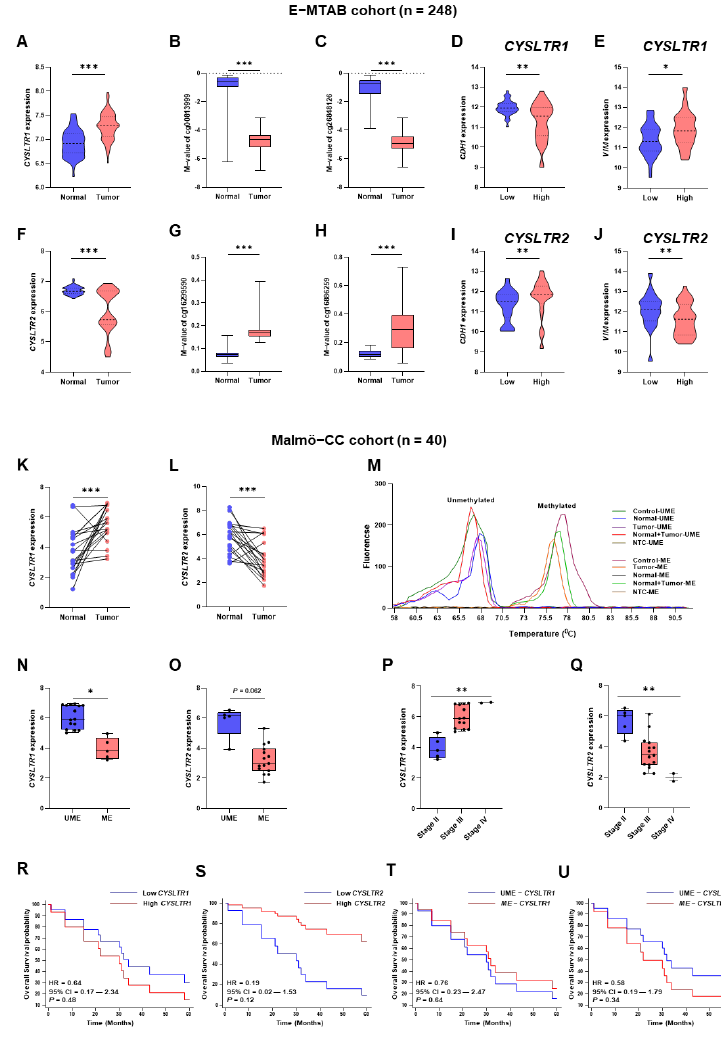
Figure 6. Expression and DNA methylation of CYSLTR1 and CYSLTR2 genes in the E-MTAB in silico and Malmö-CC clinical cohort. Relative expression of CYSLTR1 ( A ) and M-value distribution of cg00813999 ( B ) and cg26848126 ( C ) between normal and tumor samples, CDH1 ( D ), VIM ( E ) gene expressions in low- and high-expressed CYSLTR1 groups of patients in E-MTAB cohort. Relative expression of CYSLTR2 ( F ) and M-value distribution of cg16299590 ( G ) and cg16886259 ( H ) between normal and tumor samples, CDH1 ( I ), VIM ( J ) gene expressions in low- and high-expressed CYSLTR2 groups of patients in E-MTAB cohort. Relative expression of CYSLTR1 ( K ) and CYSLTR2 ( L ) gene expression between normal (N) and primary tumor (PT) samples in the Malmö cohort. ( M ) Quantita- tive methylation-specific PCR melting curve analysis in N and PT samples from the Malmö cohort. CYSLTR1 ( N ) and CYSLTR2 ( O ) gene expressions in unmethylated and methylated ( CYSLTR1 and CYSLTR2 ) patient groups in the Malmö cohort. CYSLTR1 ( P ) and CYSLTR2 ( Q ) gene expression in different stage (stage II, III and IV) tumor samples in the Malmö cohort. Five year overall survival plots for CYSLTR1 ( R ), CYSLTR2 ( S ), CYSLTR1 —unmethylated and methylated ( T ) and CYSLTR2 — unmethylated and methylated ( U ) patient samples in the Malmö cohort. HR—hazard ratio, CI— confidence interval, UME—Unmethylated, ME—Methylated, * p < 0.05; ** p < 0.01; *** p <